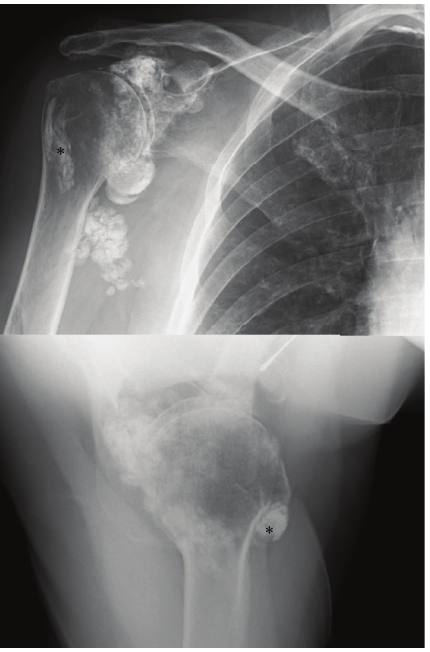
Figure 1: AP and axillary views of the right shoulder show widespread intra- and extra-articular calcinosis. Note the calcified biceps tendon in the bicipital groove, marked by an ∗ .